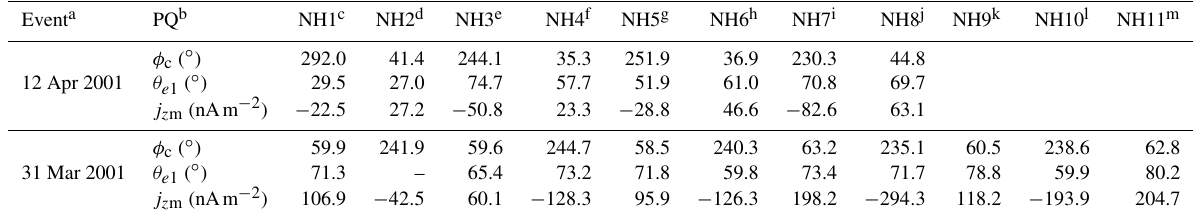
Table 1. Variation in physical quantities for two storm events. Event a